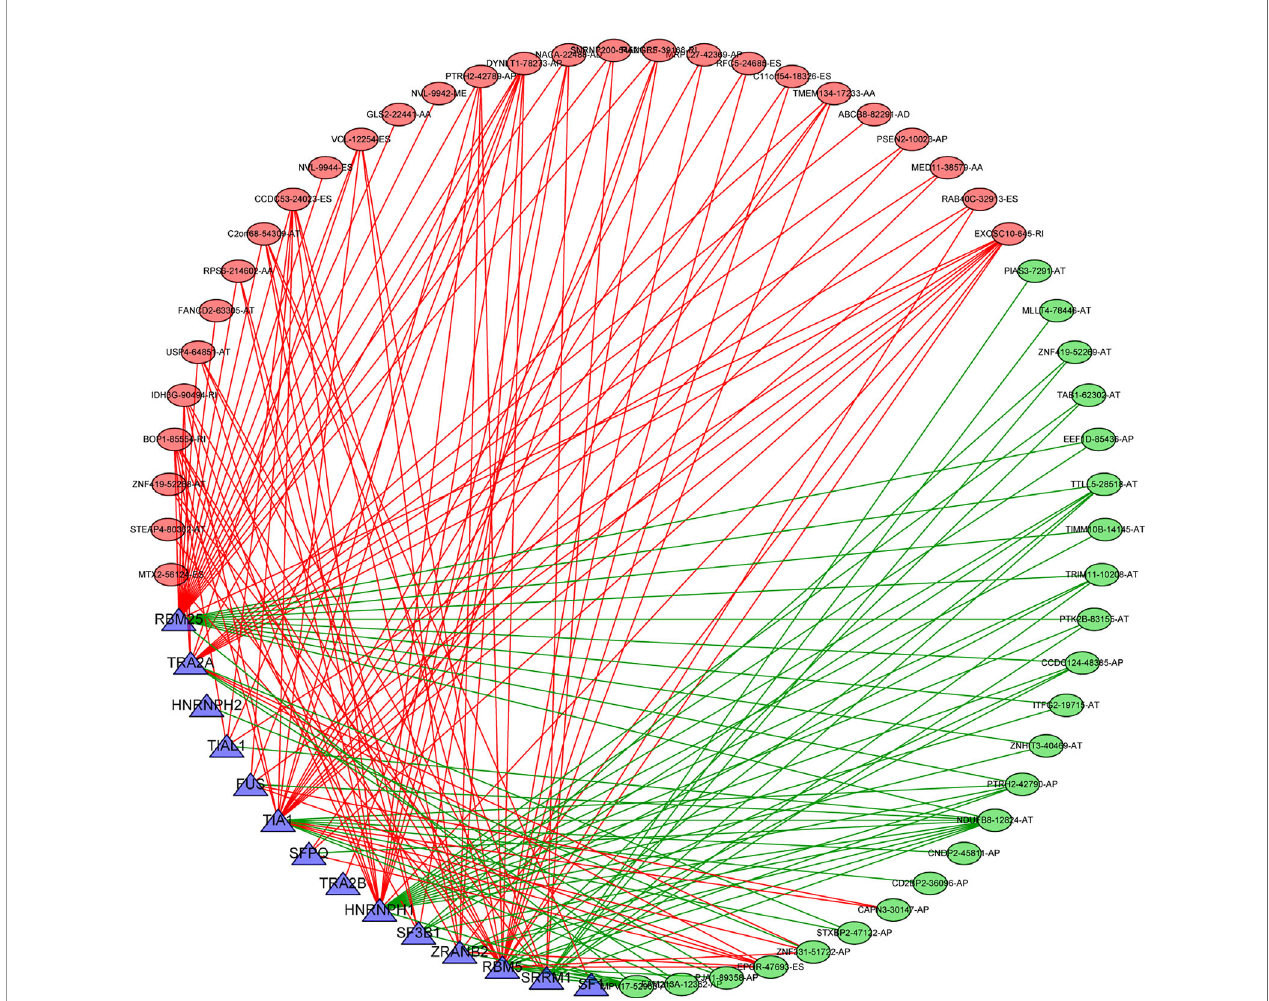
FIGURE 10 | Splicing correlation network in THCA. Seven survival-related SFs (blue triangle) were positively (green lines)/negatively (red lines) correlated with PSI values of survival-related AS events with favorable prognosis (green oval) or survival-related AS events with poor prognosis (red oval). SFs, splicing factor; AS, alternative splicing; THCA, thyroid